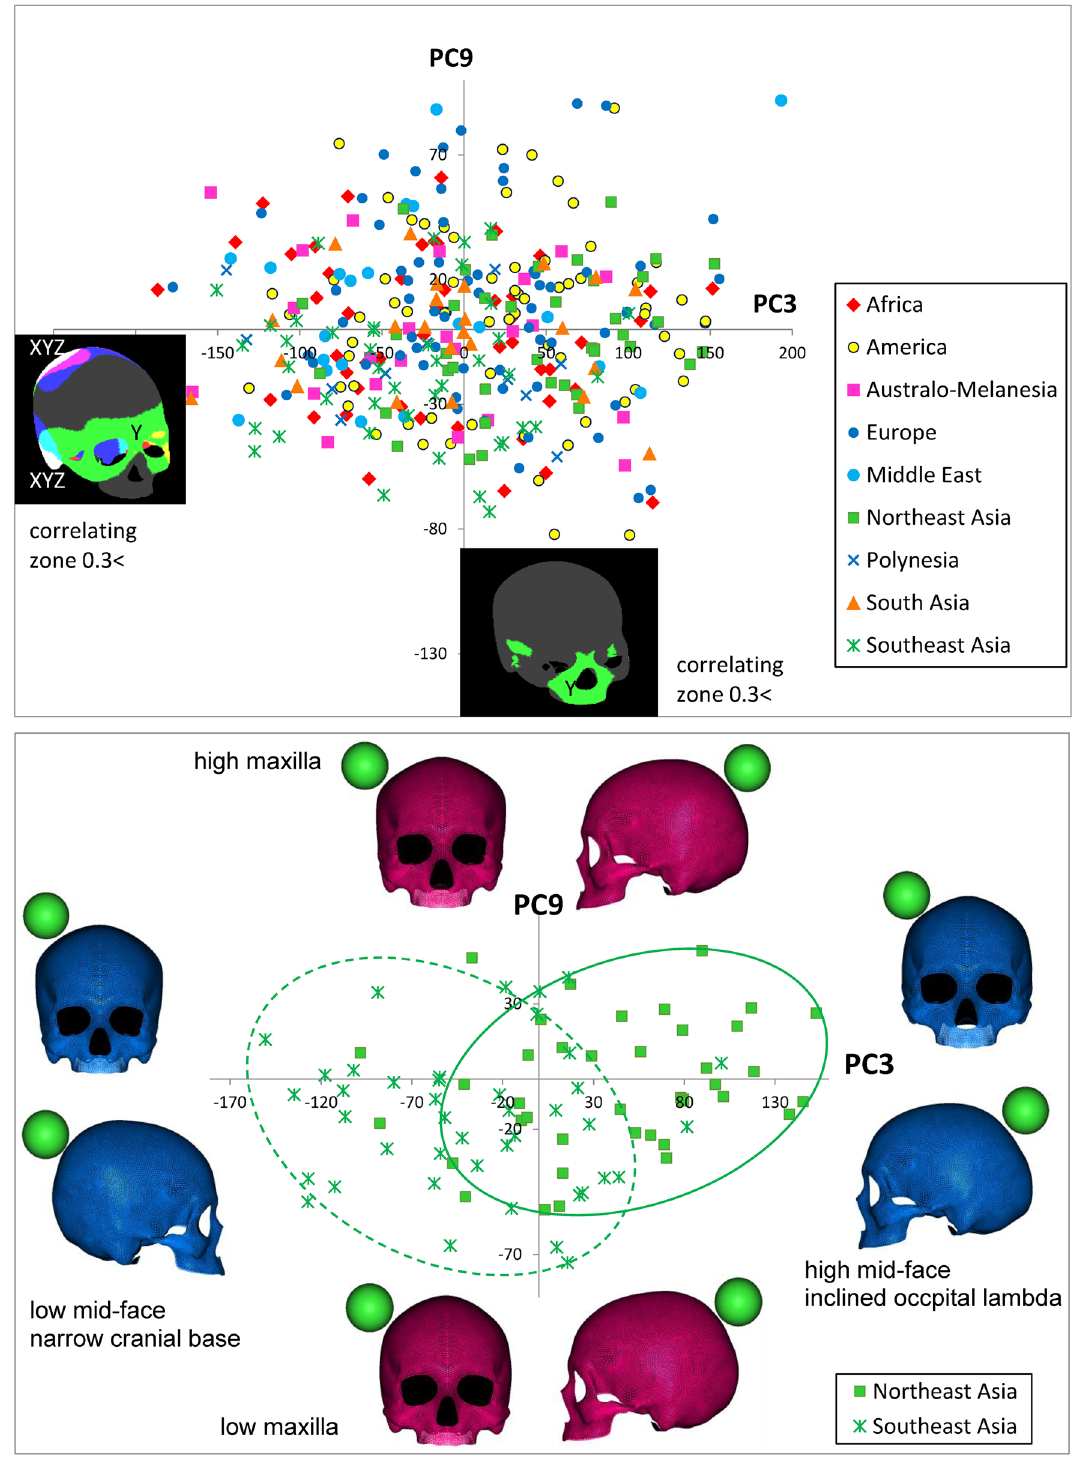
Figure 6. Scatter scoring diagrams of PC3 and PC9 for cranial individuals from nine geographical units (upper), and three geographical units (lower), color maps of cranial surface highly correlating vertices to each PC (interpretation of color against X, Y, Z axis: see text), and virtual shape deformations with a magnitude of 3 SD at the opposite sides of these axes. The scale is given as a green colored sphere of 50 mm in